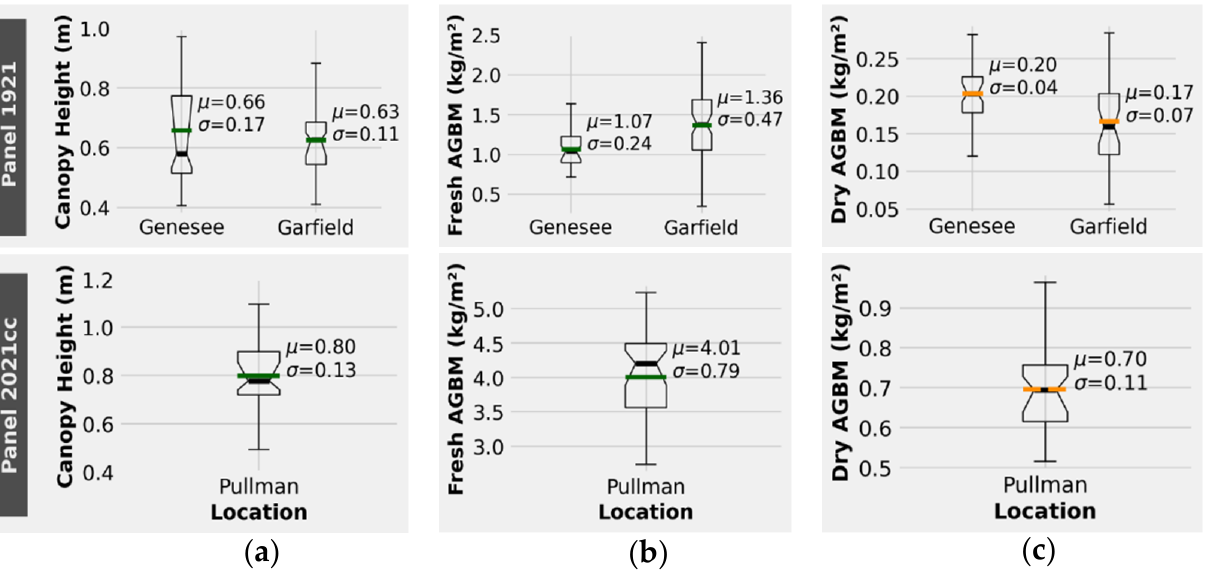
Figure 4. Ground reference data from the three trials at Genesee, Garfield, and Pullman: ( a ) canopy height; ( b ) fresh above-ground biomass; ( c ) dry above-ground biomass. µ : mean; σ : standard deviation; AGBM: above-ground biomass.